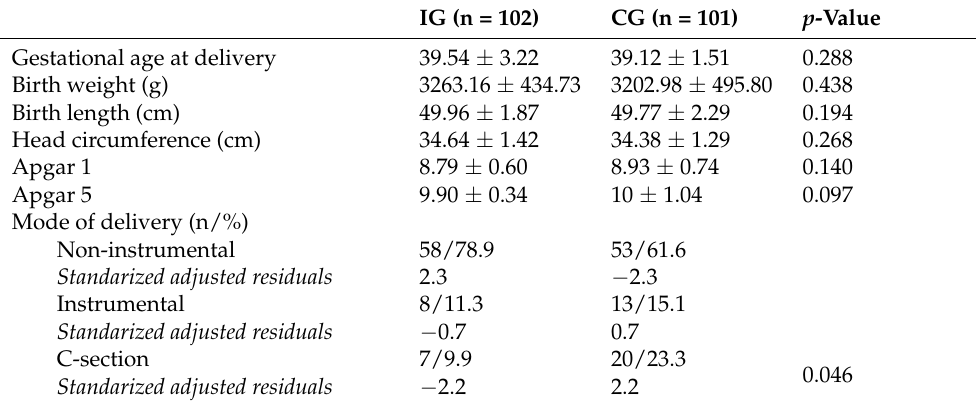
Table 5. Childbirth